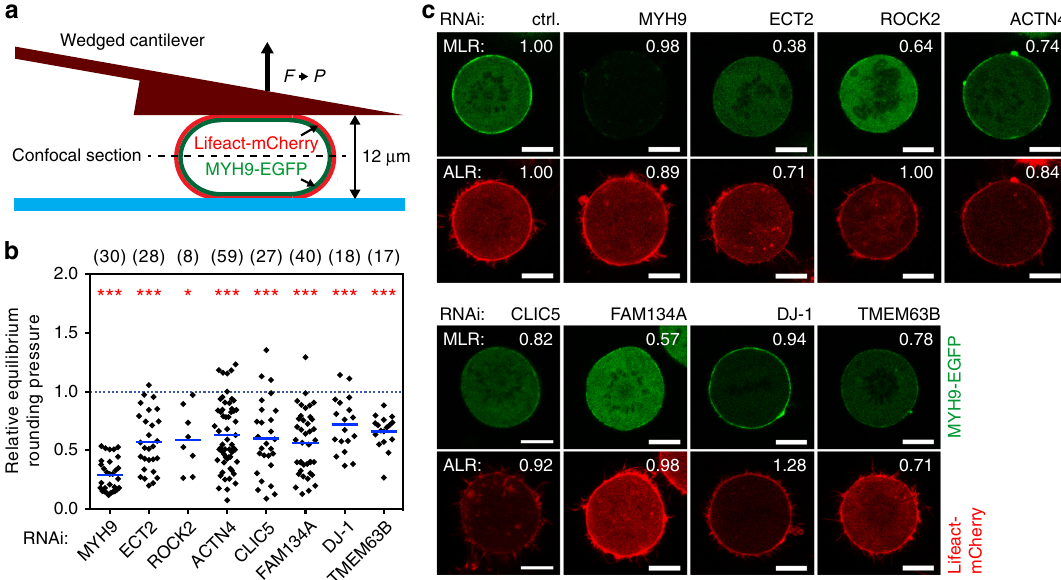
Fig. 3 Depletion of mitotic cell mechanics genes is linked to impaired cortical targeting of myosin II. a Depiction of the assay to measure rounding pressure of mitotic cells. STC-arrested mitotic cells were con fi ned to a set height of 12 µ m by a microcantilever equipped with a terminal wedge. Rounding pressure P was calculated from force F and contact area derived from images at the cross-sectional midplane (Methods). Cortex to cytoplasm ratio of fl uorescence markers for myosin II ( MLR myosin localization ratio) and actin ( ALR actin localization ratio) were calculated as described in Methods 11 . b Relative equilibrium rounding pressure of STC-arrested con fi ned mitotic cells depleted of the indicated proteins by RNAi. Blue dashed line, average control rounding pressure, normalized to one. Each black diamond represents one cell. ‘ ( n ) ’ denotes number of cells measured. Blue bars, mean. Statistical signi fi cance was determined by Mann – Whitney U -test (* p ≤ 0.05; *** p < 0.001). c Representative fl uorescent confocal images of STC-arrested con fi ned mitotic cells expressing markers for myosin II (MYH9-EGFP) and F-actin (Lifeact-mCherry), depleted of selected proteins as indicated. MLR and ALR, relative to control cells, are shown at the top right of each image. Scale bars, 10 µ m. See Supplementary Fig. 5 for full results of rounding pressure and MLR/ALR for all